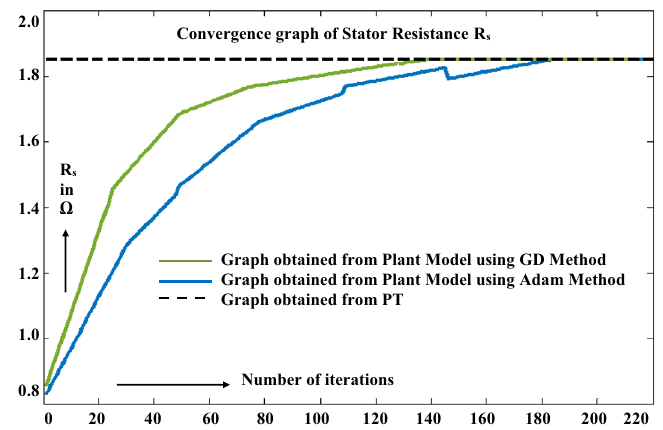
Fig. 10 Convergence of BPANN based estimation of stator resistance R s